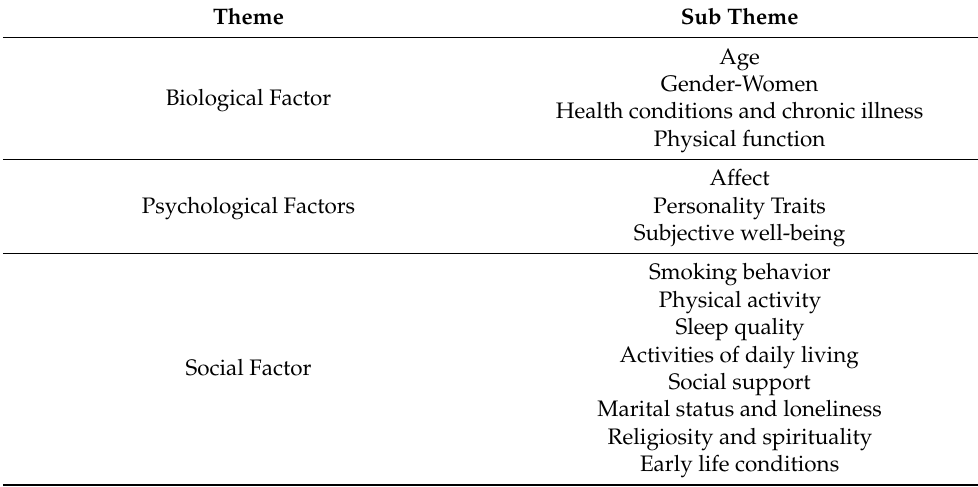
Table 2. Code and theme extracted of literatures